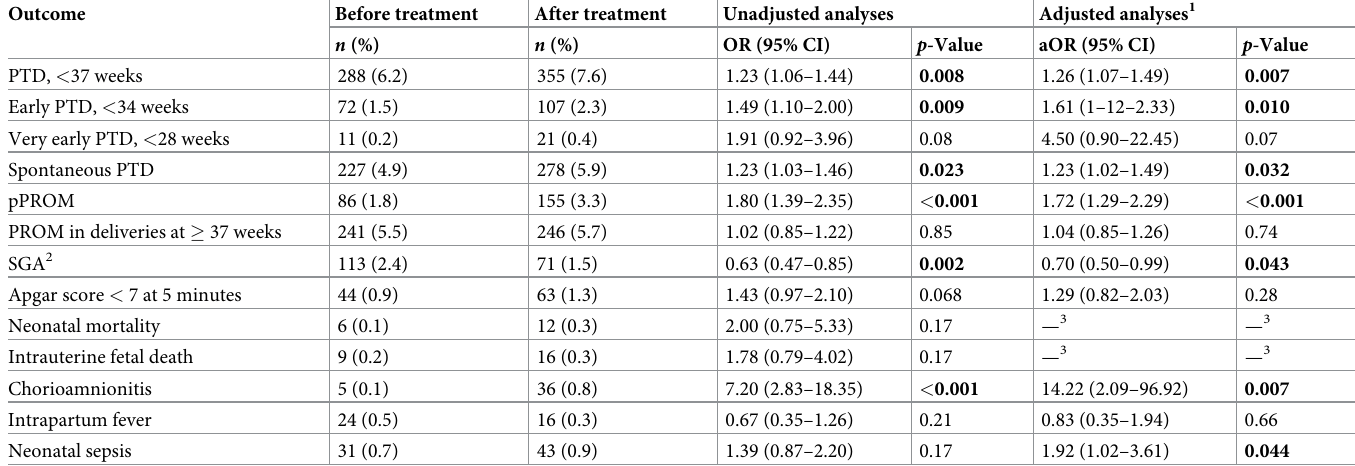
Table 5. Obstetric and neonatal outcomes in paired analyses of a woman’s last delivery before treatment and first delivery after treatment—conditional logistic regression analysis ( n = 4,680 women).